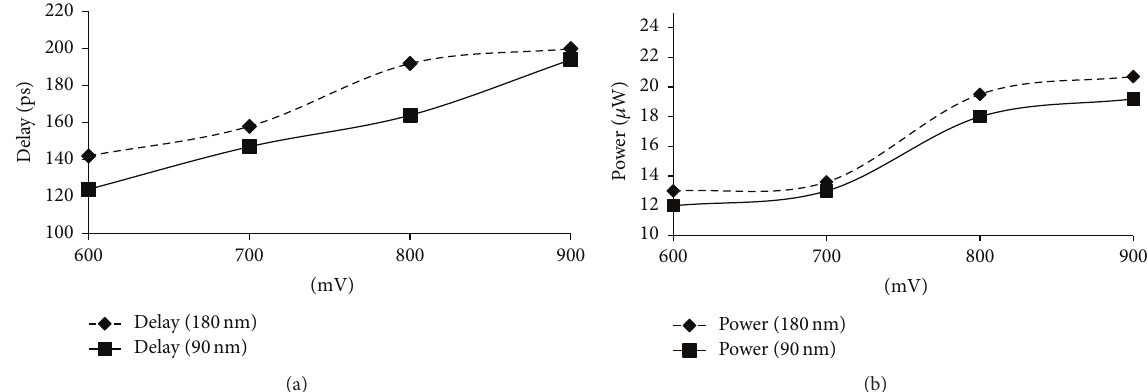
Figure 8: Performance of the two-input H-DyCML XOR gate by varying the voltage swing: (a) delay results: (b) power